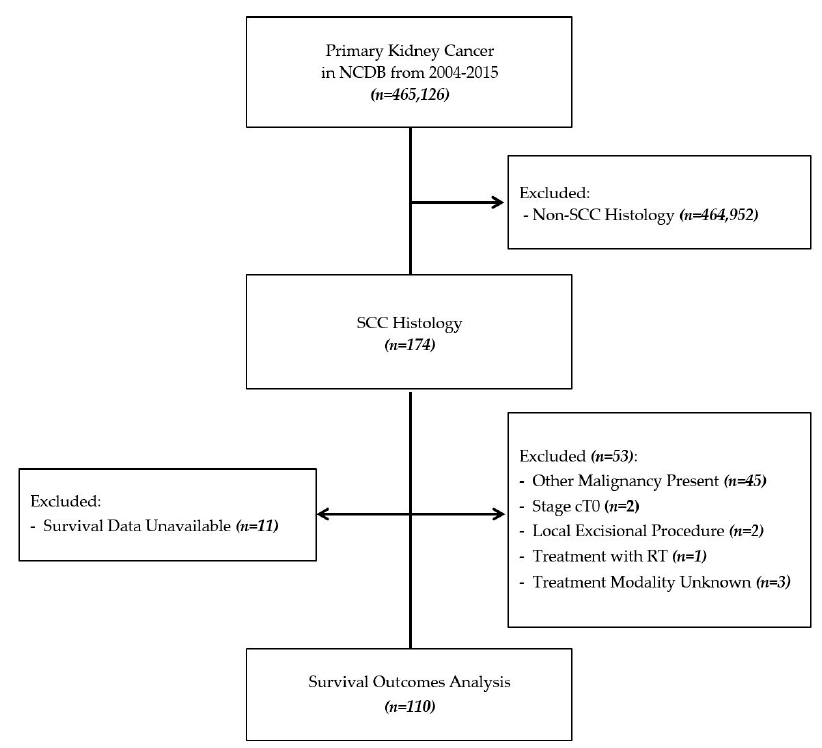
Figure 1. Selection map.